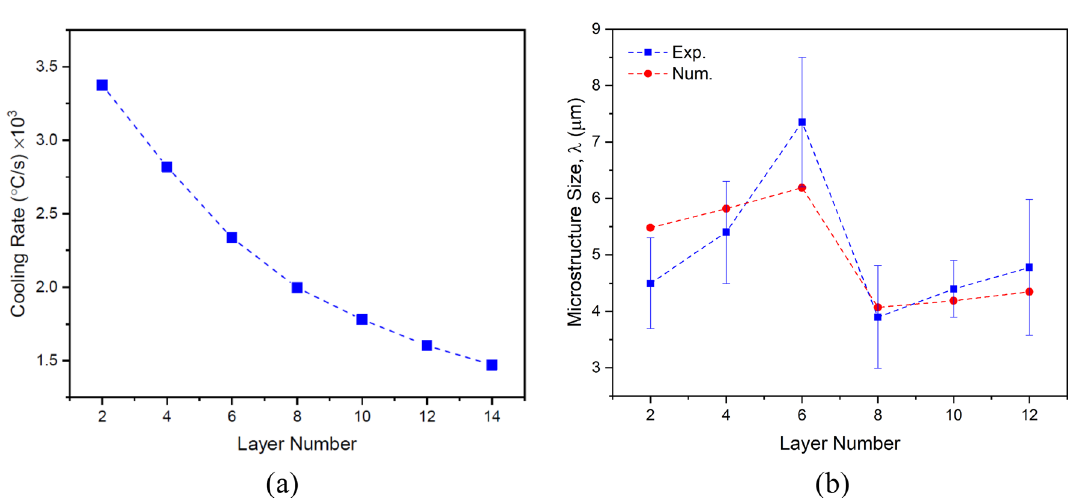
Figure 11. The variations of ( a ) the cooling rate in the solidification range and ( b ) the microstructure size (i.e. cellular/dendritic arm spacing, (cid:31) ) in the build